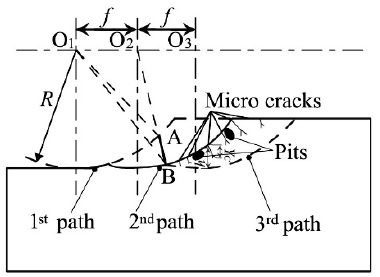
Figure 15. Formation of crack-free surface in the processing by circular edge cutting tool [74].